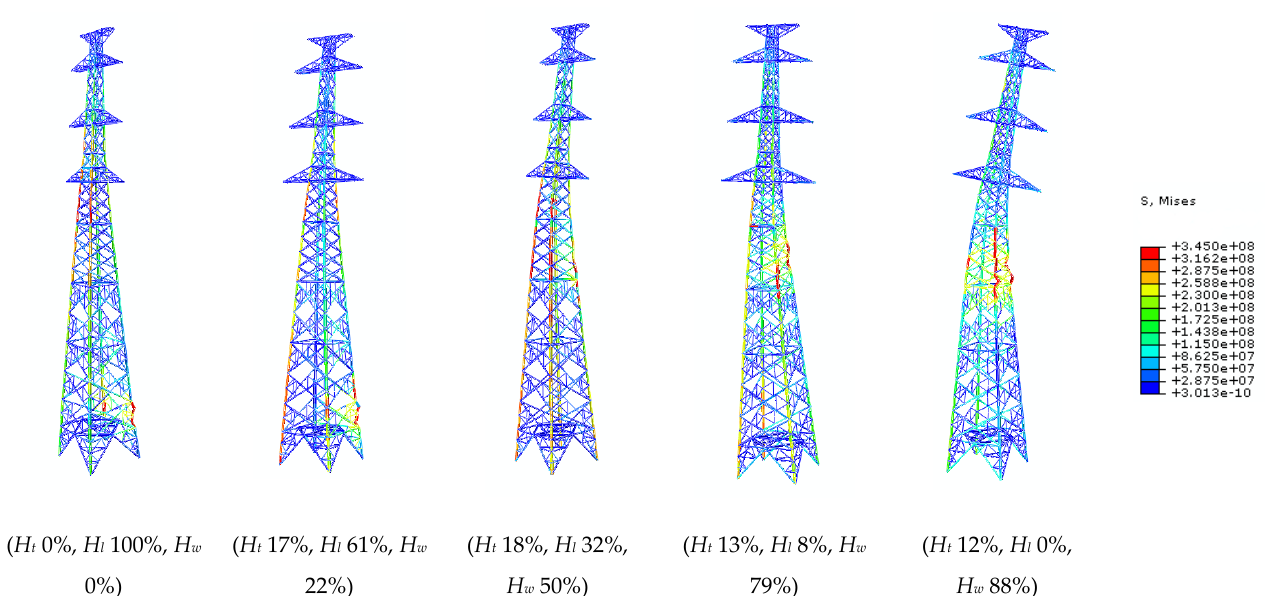
Figure A2. Failures of tower ZY under different combination ratios of three wind load components.